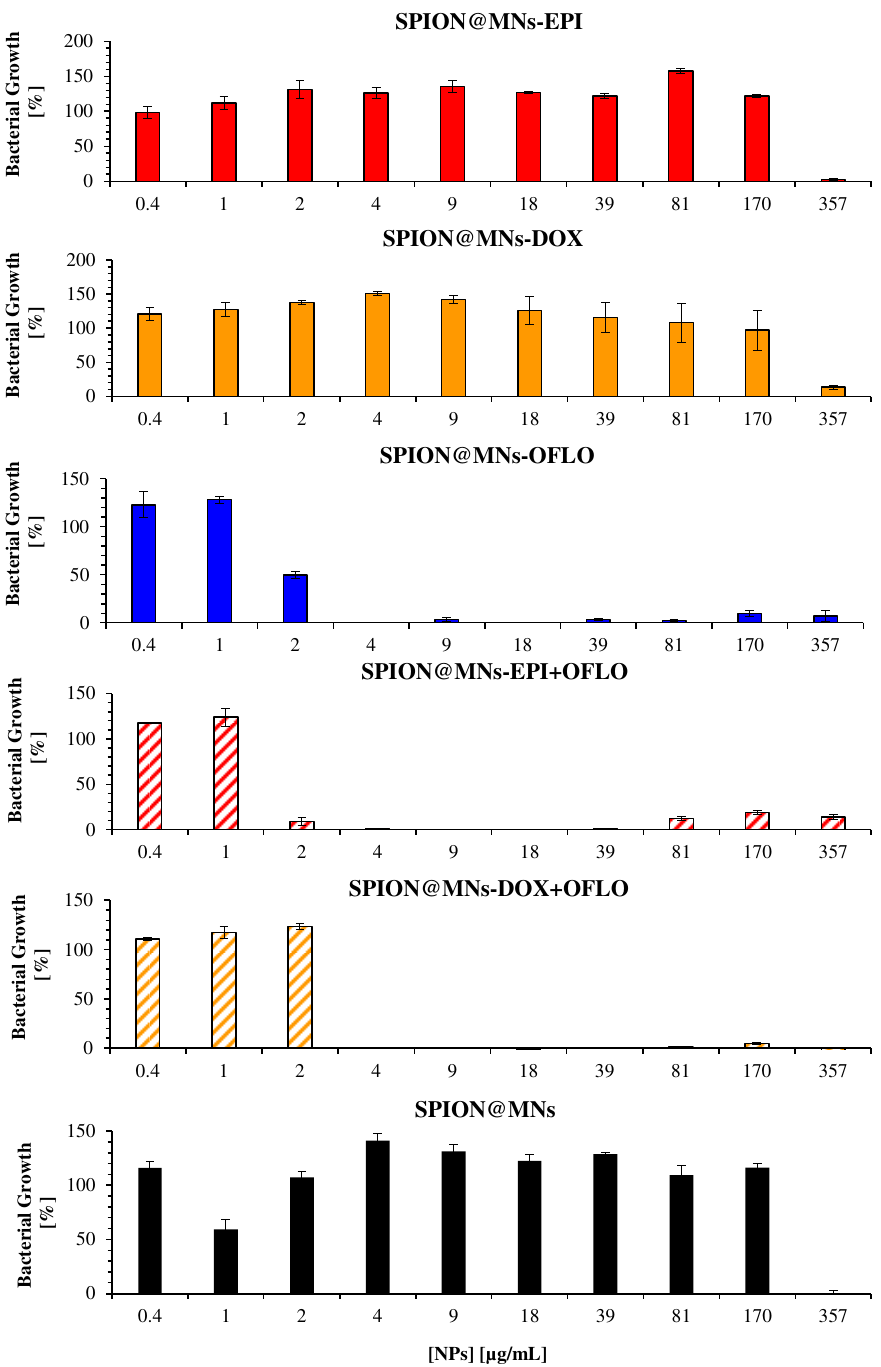
Figure 8. Antimicrobial activity of drug-loaded SPION@MNs on the parental E. coli strain, measured as the bacterial growth calculated by OD 600 , for 24 h assay.